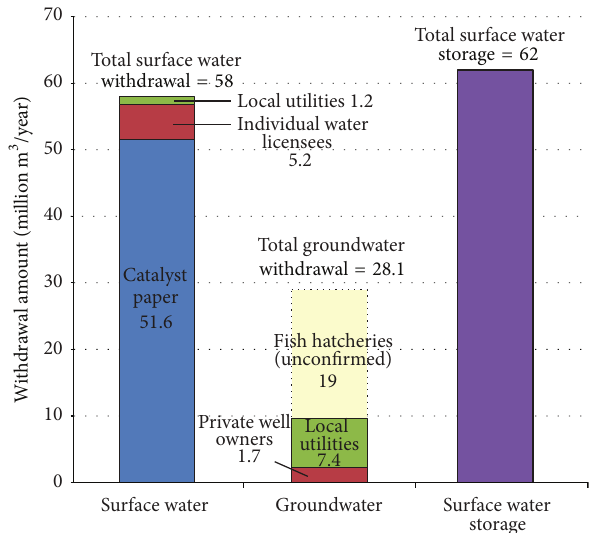
Figure 2: Water use according to user group within the Cowichan